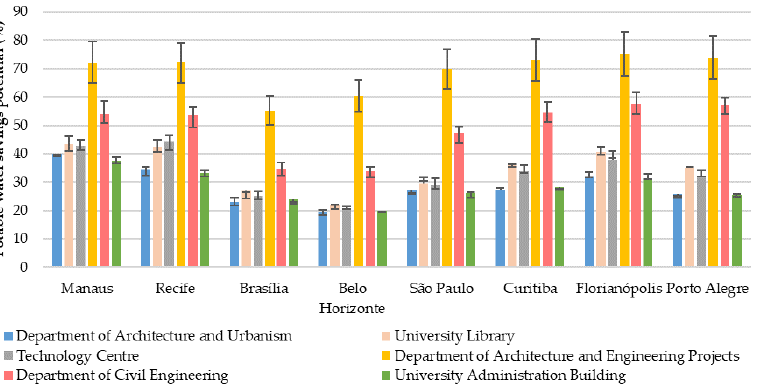
Figure 8. Potable water savings potential for the average rainwater demand (77%), minimum (69%) and maximum